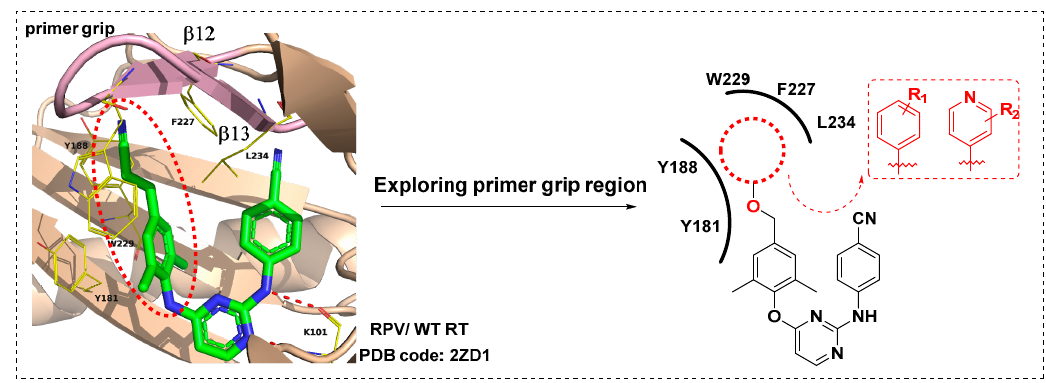
Figure 4. Design strategy of target compounds.